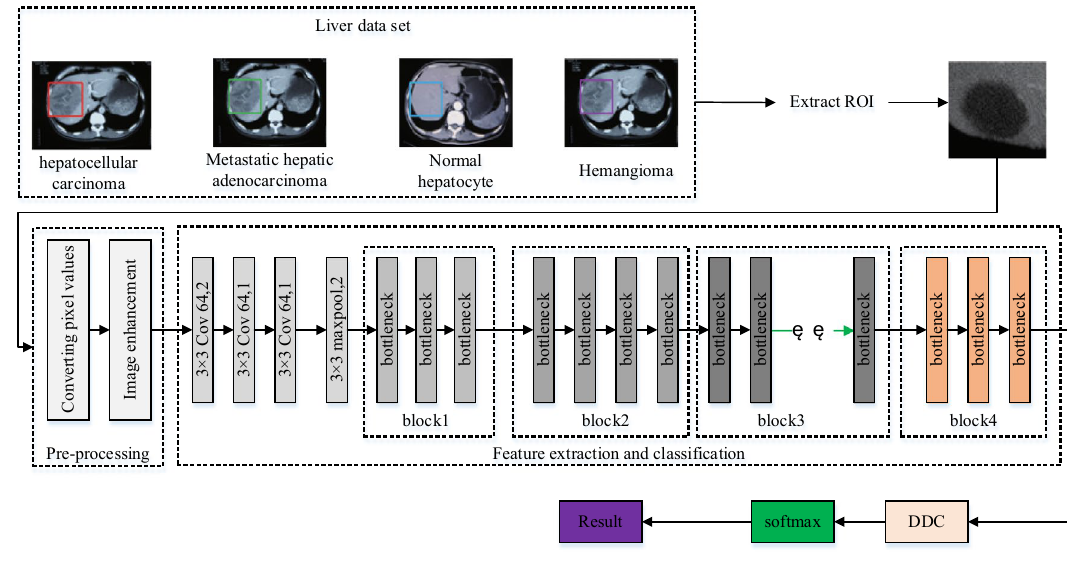
Fig. 6 Overview of the proposed